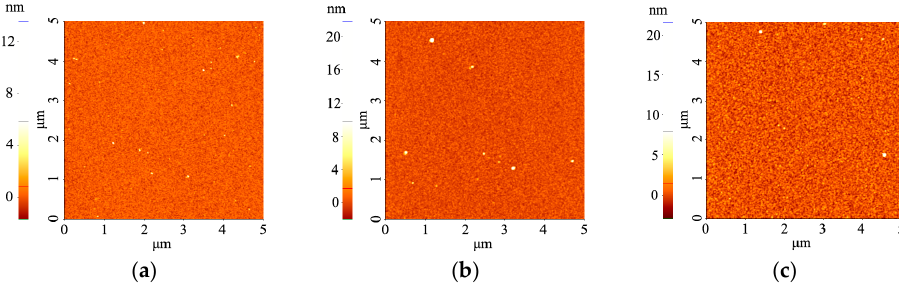
Figure 3. Atomic Force Microscopy (AFM) images of magnetron sputtered PTFE-like thin films